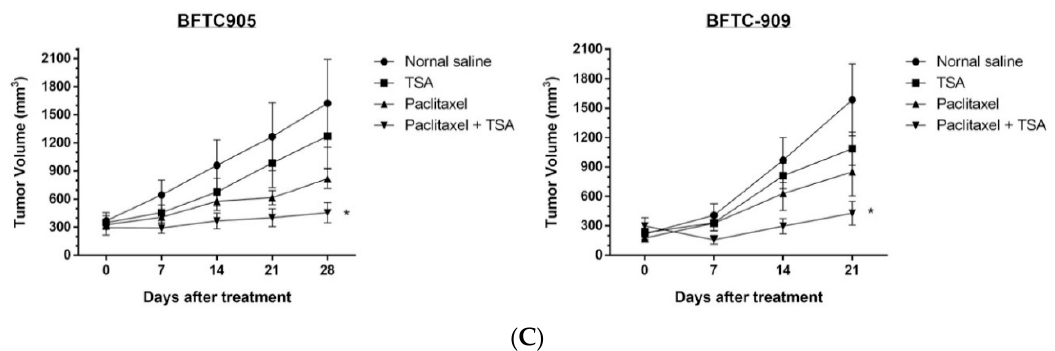
Figure 5. BFTC-905 and BFTC-909 xenograft in nude mice under TSA and paclitaxel cotreatment revealed a significant inhibition of tumor volume growth. The lateral sides of the nude mice 6–8 weeks old were xenografted with BFTC-905 or BFTC-909 cells ( n = 5 mice per group). Drug treatments were administered three times each week for a month, starting 2 weeks after xenograft (1 mg TSA/kg, 2 mg paclitaxel/kg, intraperitoneally). ( A ) Tumors after 4 weeks of treatment, ( B ) tumor weight progression over 4 weeks of treatment, and ( C ) tumor volume progression over 4 weeks of treatment ( n = 6 tumors, data are presented as mean ± SEM). Tumor volumes show significant differences between the control and combined groups at week 4 (one-way ANOVA). * p < 0.05.